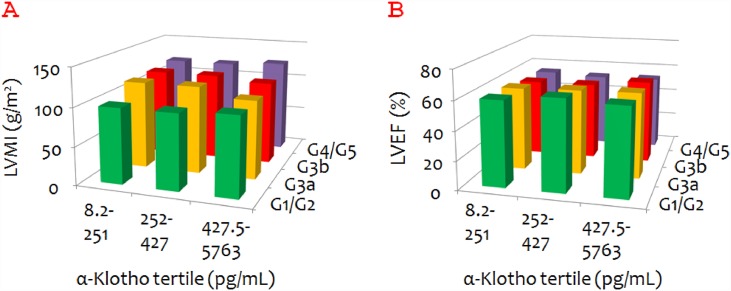
Mean left ventricular mass index (LVMI) and left ventricular ejection fraction (LVEF) according to α-Klotho tertile and chronic kidney disease (CKD) stage.A. Mean LVMI according to α-Klotho tertile and CKD stage. B. Mean LVEF according to α-Klotho tertile and CKD stage.